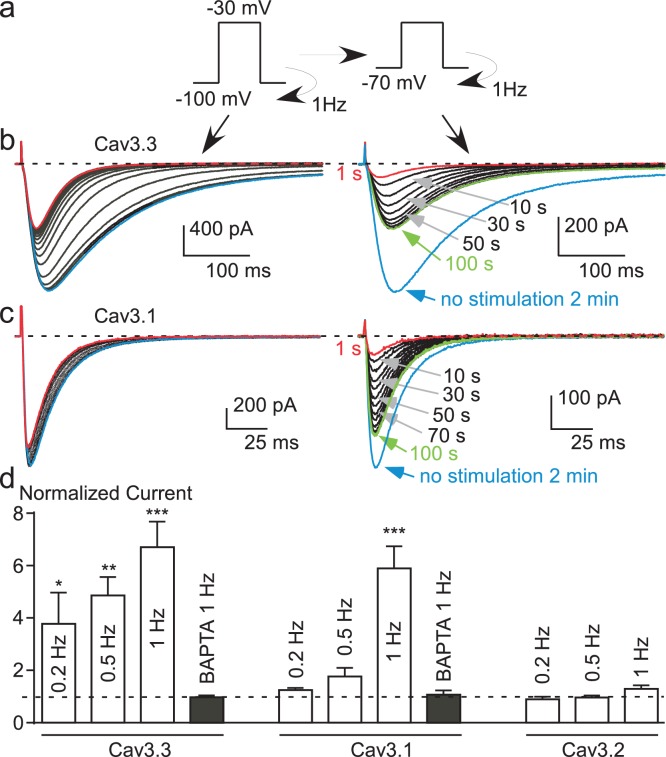
Potent T-type current recovery at physiological resting potentials.(a–c) Fast TP stimulation (TP −30 mV) using HP of −100 mV to induce inhibition, switched to a HP of −70 mV to induce recovery (see protocol in (a)). The inhibition of Cav3.3 and Cav3.1 currents was measured using fast TP stimulation at a HP of −100 mV (b–c, left panels) whereas the recovery of the Cav3.3 and Cav3.1 currents was measured on a HP of −70 mV (b–c, right panels). (d) Quantification of the increase (recovery) in Cav3.3, Cav3.1 and Cav3.2 currents (at HP −70 mV) as a function of the TP stimulation frequency (n = 5–40 per bar). The normalized current corresponds to the ratio of the current obtained after 2 min without stimulation (blue trace) to the initial current (1 s, red trace) recorded at a HP −70 mV.